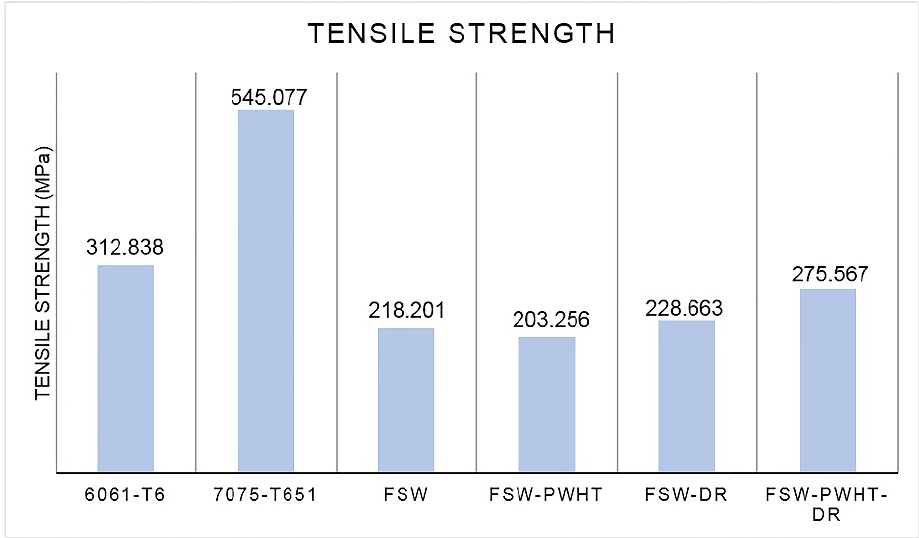
Figure 13. Tensile strength of the workpieces.